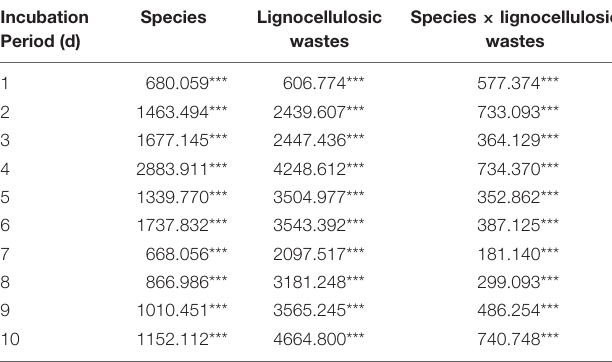
TABLE 2 | Two-way ANOVA of variance to examine the effects of species, lignocellulosic wastes, and the interactions of species and lignocellulosic wastes on laccase activity.